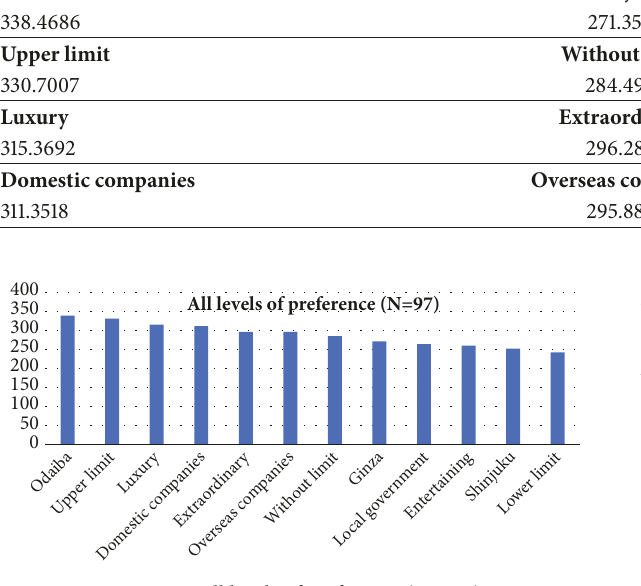
Figure 4: All levels of preference (N =